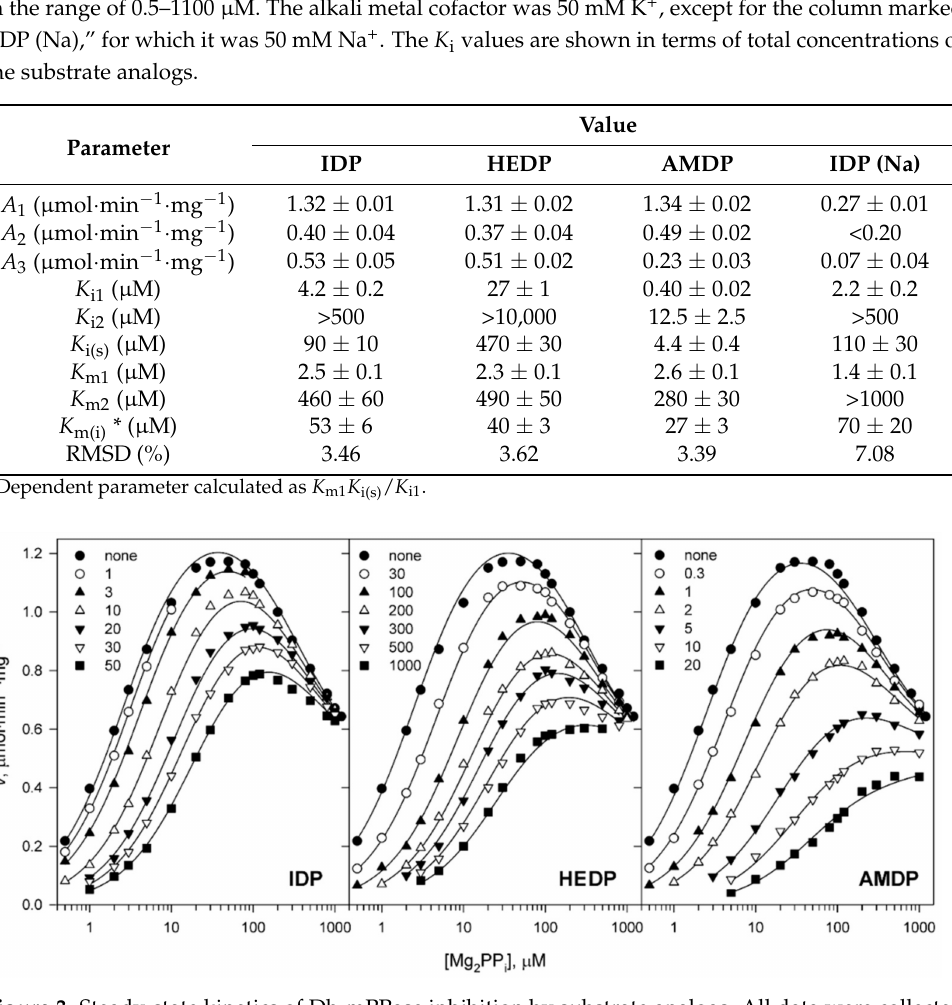
Figure 3. Steady-state kinetics of Dh-mPPase inhibition by substrate analogs. All data were collected with 5 mM Mg 2+ and 50 mM K + as the alkali metal cofactor. The abscissa shows substrate (Mg 2 PP i ) concentration and is scaled logarithmically. The total concentrations of substrate analog (in µ M) corresponding to different symbols are defined on each panel. Its solubility limited the range of its concentrations used. The lines were calculated using Equation (2) with the parameter values found in Table